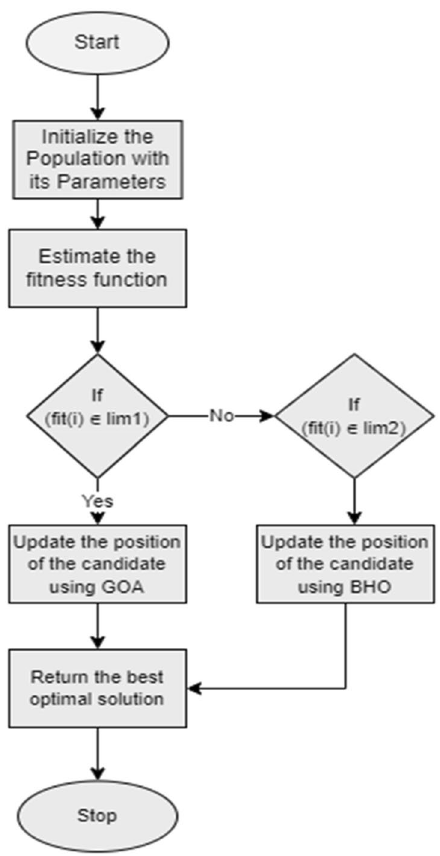
Figure 3. Flowchart of the Proposed